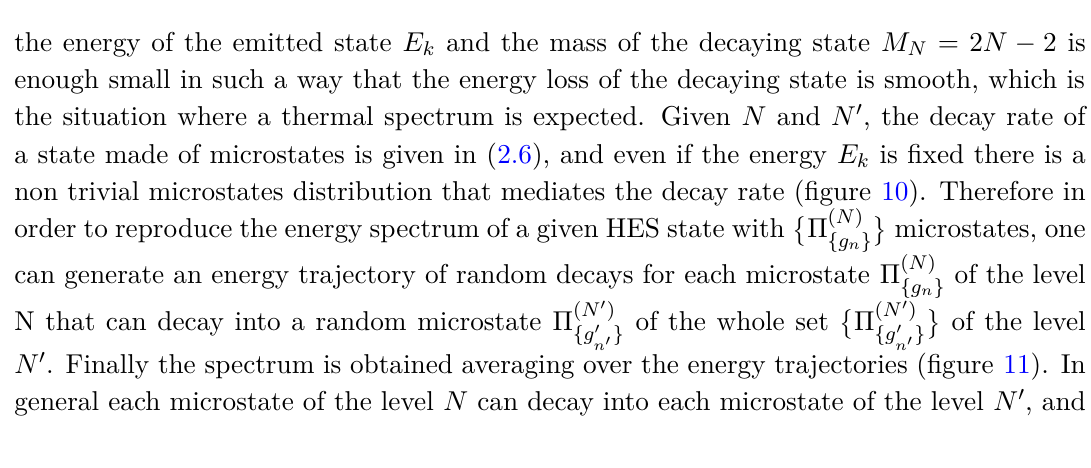
} of N 0 = 99 . The red points are the values of the n 0